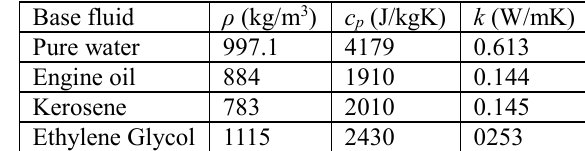
Thermal-physical properties of the base fluid [39–41][50,51].